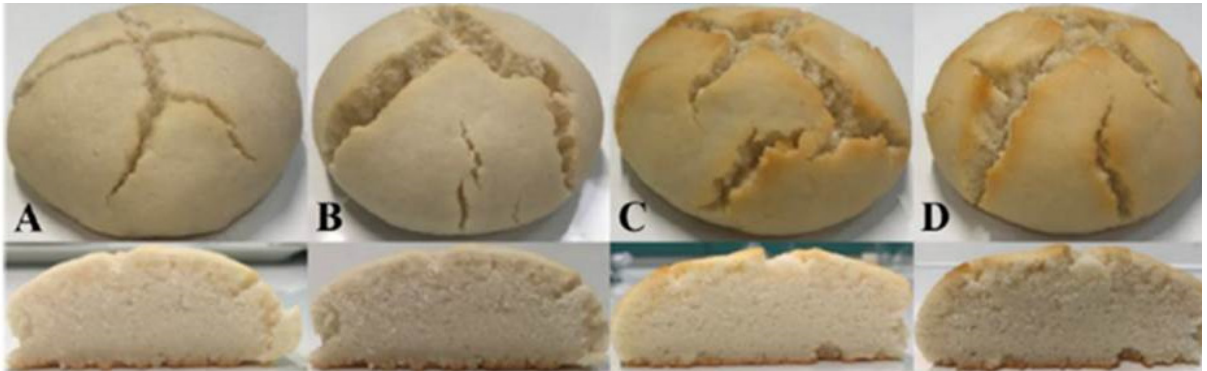
Figure 2. Gluten-free bread sample: PB (bread prepared without kefir) ( A ), PKB50 (bread prepared with 50 mL of kefir) ( B ), PKB150 (bread prepared with 150 mL of kefir) ( C ), PKF5 (bread prepared with 150 mL of kefir fortified with CSU2 (5.0 mg per gram of kefir) ( D ). Antioxidant activities both in organic and aqueous environments of gluten-free bread were evaluated as a function of time (6 days), and the results are reported in Table 5. Antioxidant activities of gluten-free bread as a function of time. Each measurement was carried out in triplicate, and data are expressed as means (±SD).